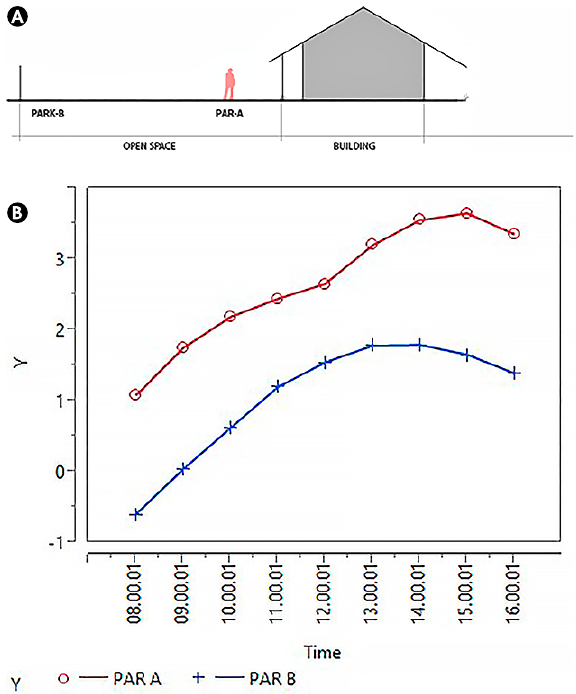
Figure 17. Section of PAR-A and PAR-B (b) Comparison of PMV at 2 points location in the PAR